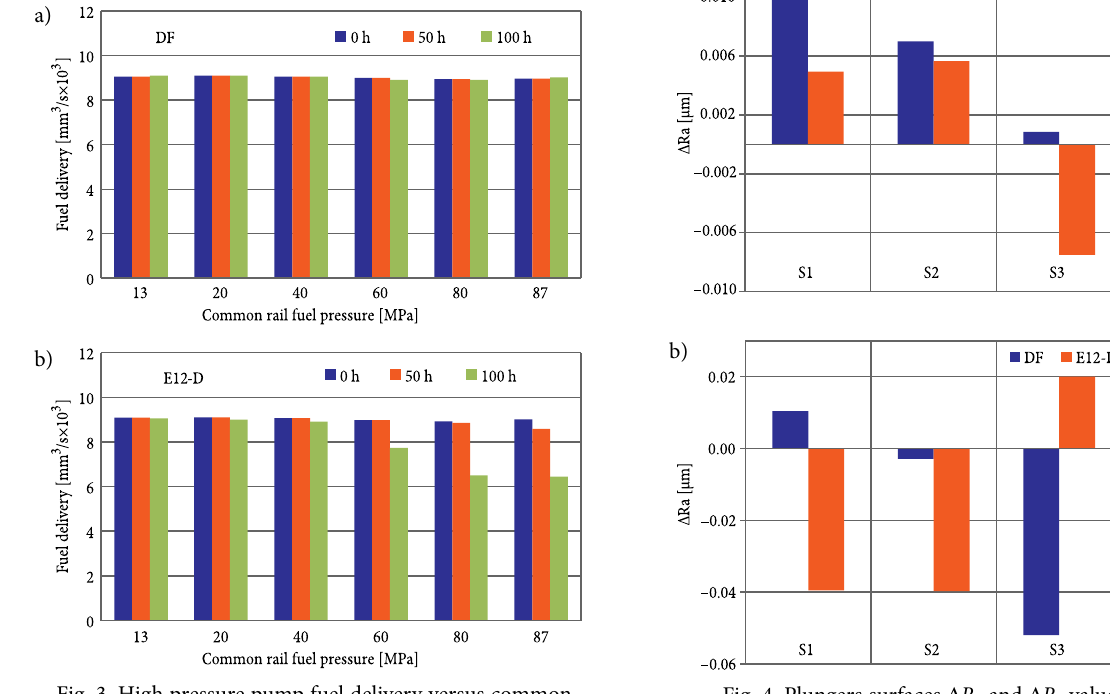
Fig. 4. Plungers surfaces D R a and D R z values for both